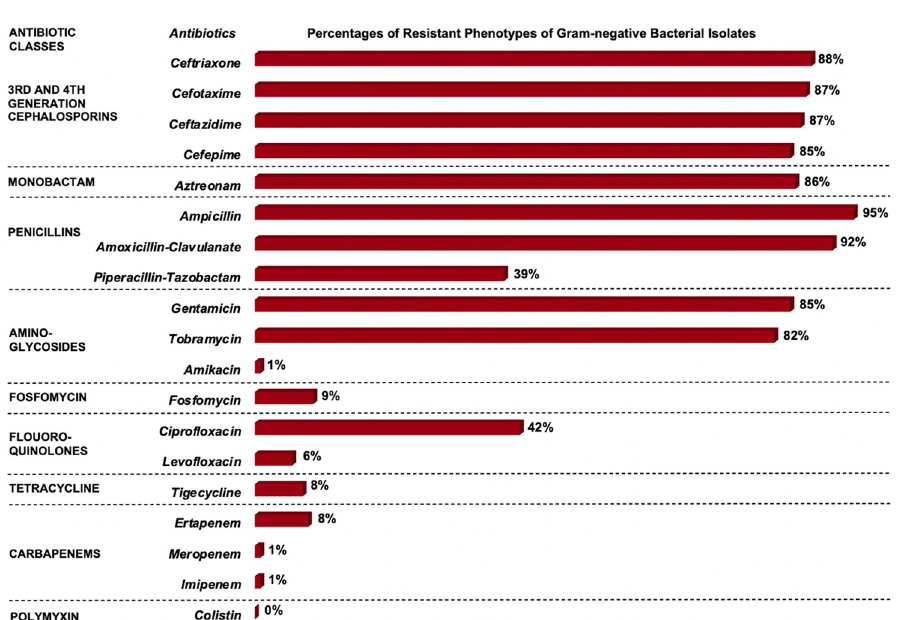
Fig 7. Prevalence of gram-negative resistant phenotypes. Over 80% of the 119 gram negative isolates were resistant to 3 rd and 4 th generation cephalosporins, monobactams, and penicillins (with the exception of piperacillin- tazobactim), and aminoglycosides (with the exception of amikacin). Less than 10% of isolates were resistant to amikacin, fosfomycin, levofloxacin, tigecycline, colistin, and all the carbapenems.